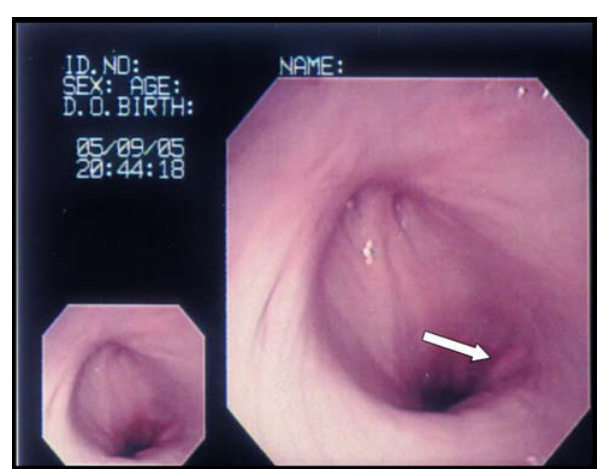
FIGURE 4 - Endoscopic image of dog’s esophagus submitted to esophagoplasty with diaphragmatic